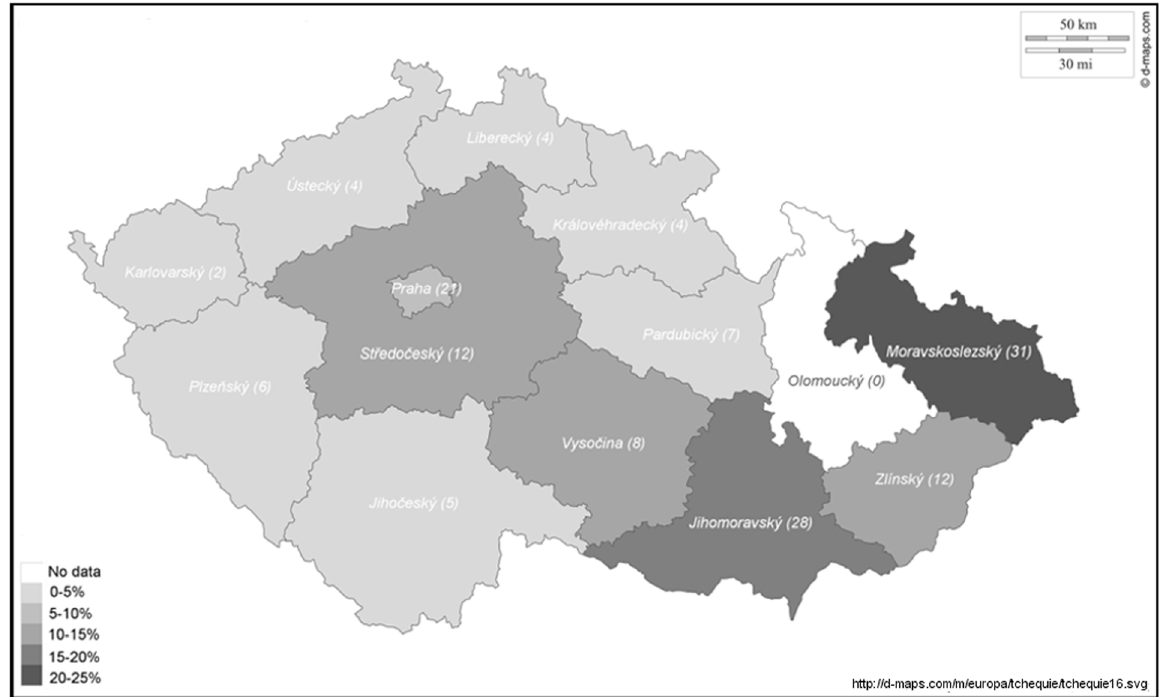
Figure 1. Numbers of COPD specialists involved in the research by country regions of the Czech Republic.